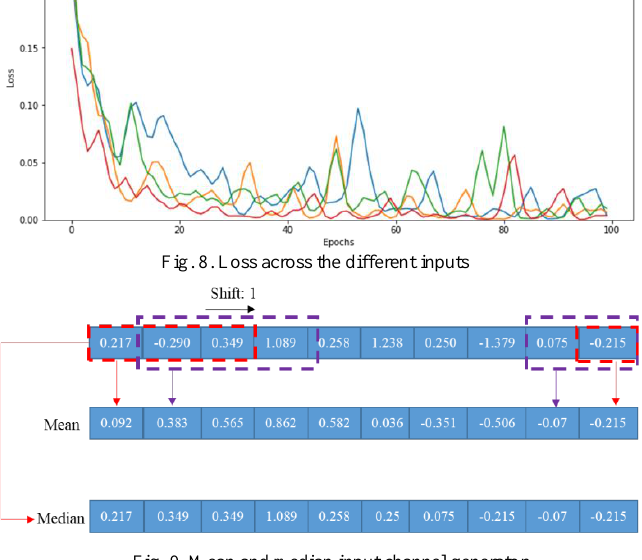
Fig. 9. Mean and median input channel